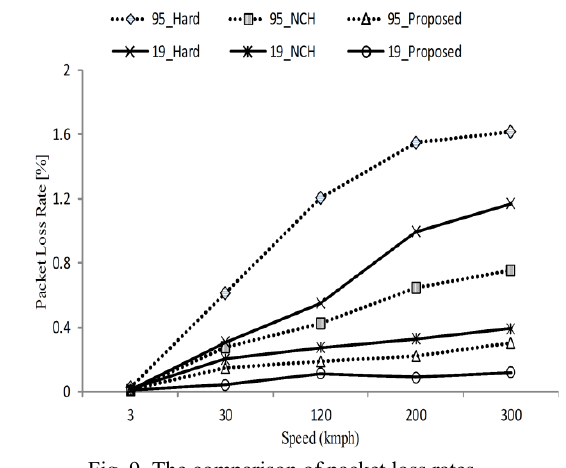
Fig. 9. The comparison of packet loss